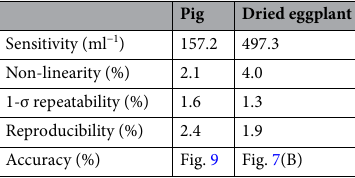
Table 2. Metrological pig abdominal non-perfused muscle characteristics.